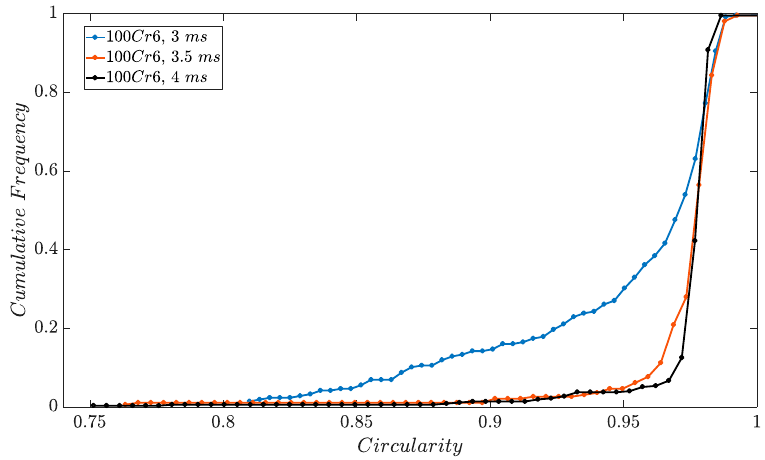
Figure 11. Average circularity of the spheres from image analysis, 0.973 ± 0.029.